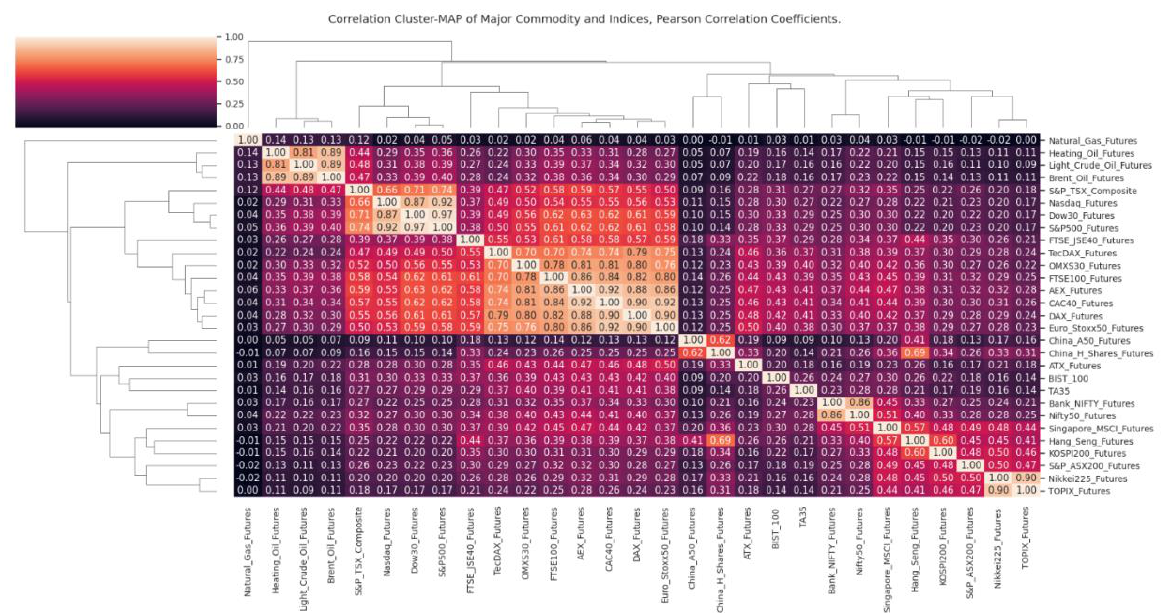
Figure 3: Correlation cluster map of global commodity futures from the fossil energy, agricultural and metals sector; daily returns over the period 2012-2018 were